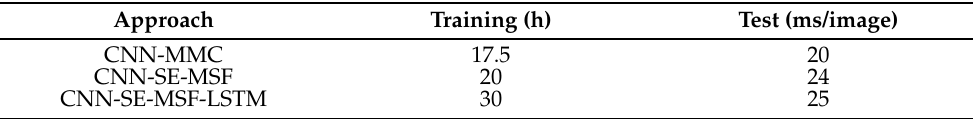
Table 6. Computation times of the evaluated approaches. An NVIDIA RTX A6000 GPU was used for